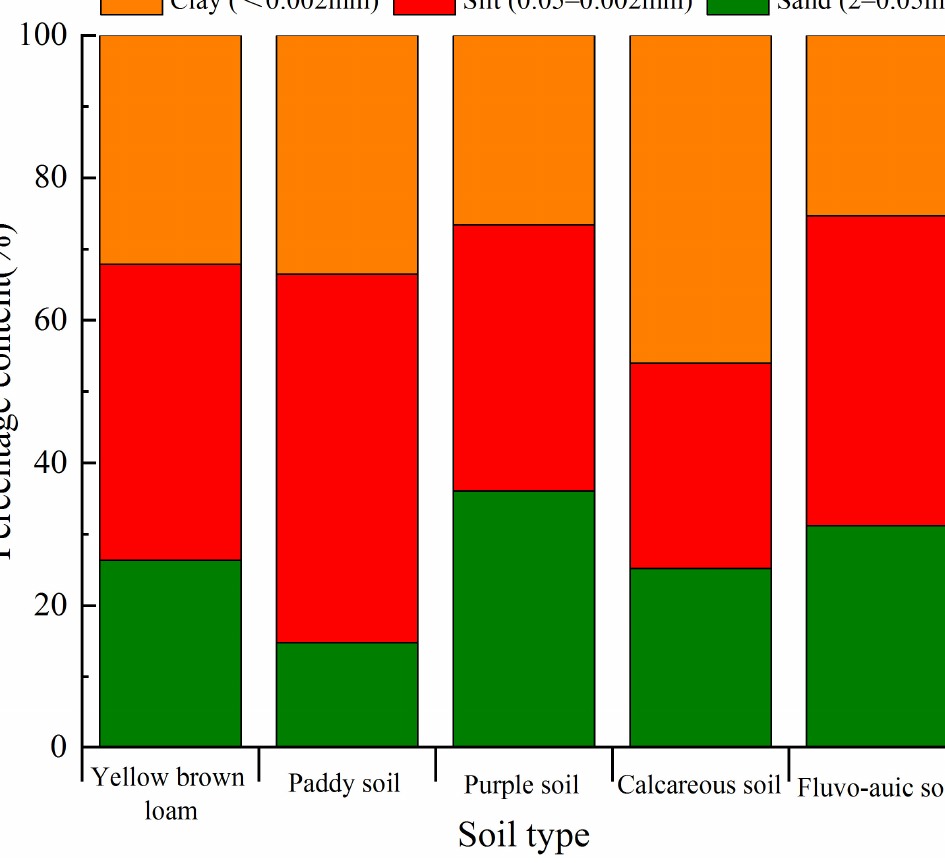
Figure 3. Different soil types of mechanical composition.